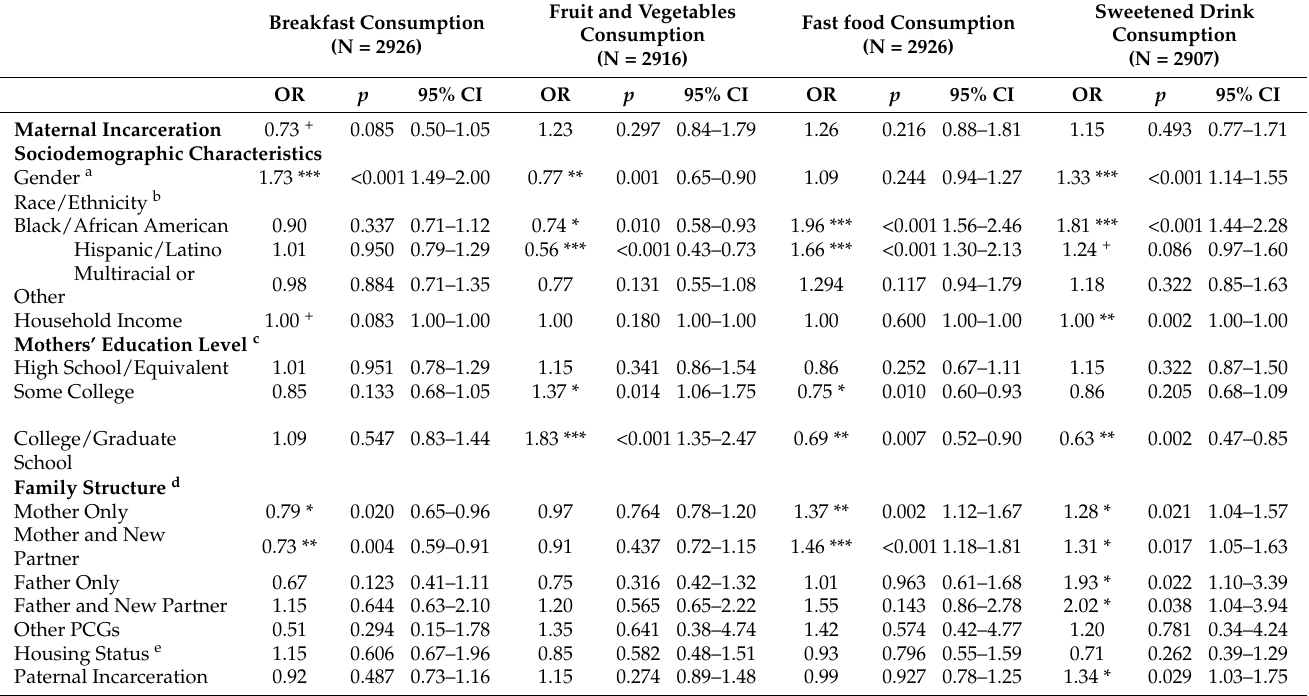
Table 4. Logistic regression models on the association between maternal incarceration and adolescents’ dietary behaviors